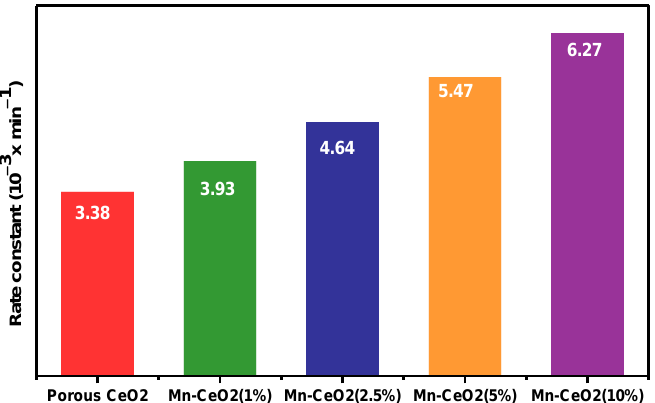
Figure 9. The pseudo first order rate constants of the investigated materials. The sample with 10% Mn exhibited 1.8 times more activity than the neat porous ceria sample.